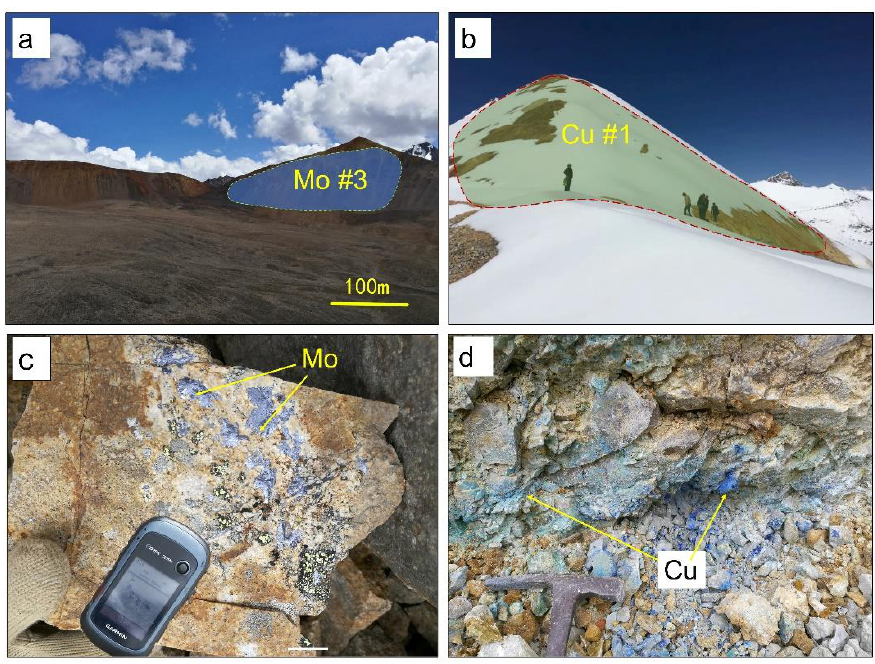
Figure 2. Photographs of the ore field and outcrops with Mo, Cu mineralization. ( a ) Locality of Mo#3; ( b ) Locality of Cu#1; ( c ) Molybdenum mineralization phenomenon; ( d ) Oxidized copper mineralization phenomenon. Abbreviations: Mo = molybdenite, Cu = copper-bearing minerals (e.g., malachite and azurite).